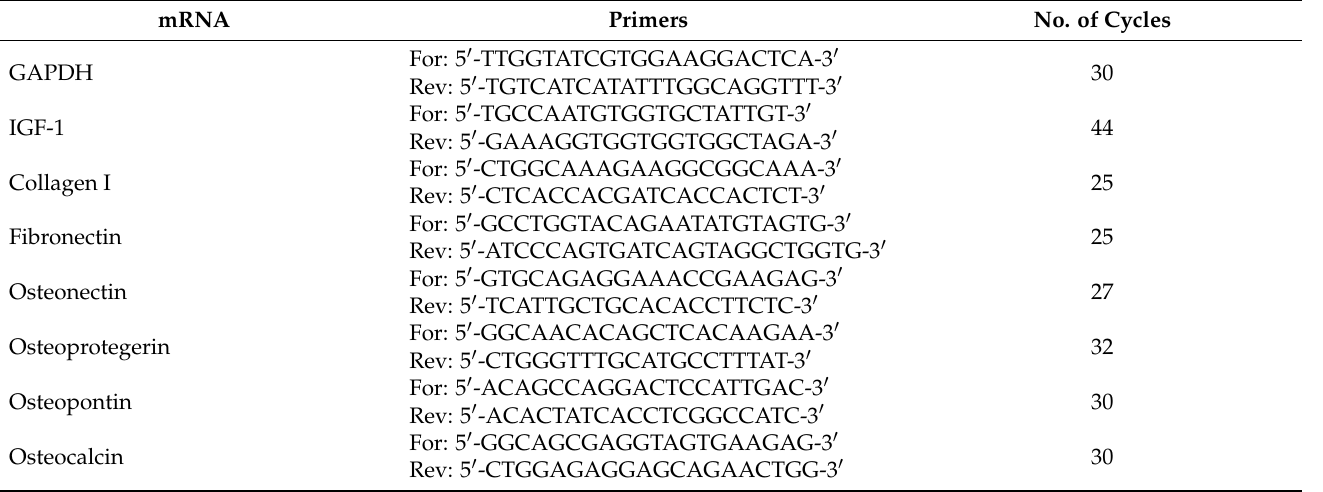
Table 1. Primer sequences exploited for gene expression